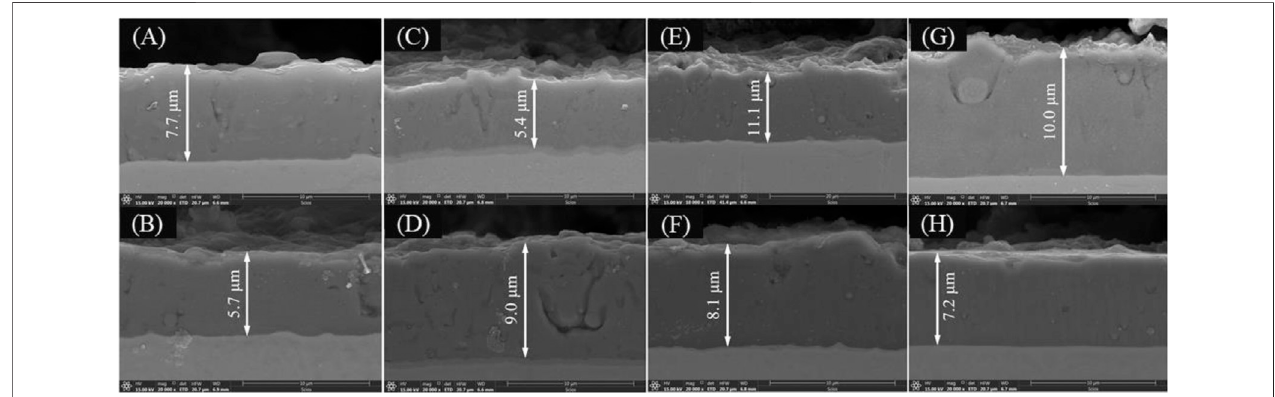
FIGURE7| Cross-sectionalSEMimagesofeachATFcandidatecladding(depositiontime:2 h), (A) uppersideand (B) lowersideofCr 32.1 Al 67.9 , (C) uppersideand (D) lower side of Cr 45.8 Al 54.2 , (E) upper side and (F) lower side of Cr 32.1 Al 67.9 N, (G) upper side and (H) lower side of Cr 45.8 Al 54.2 N.